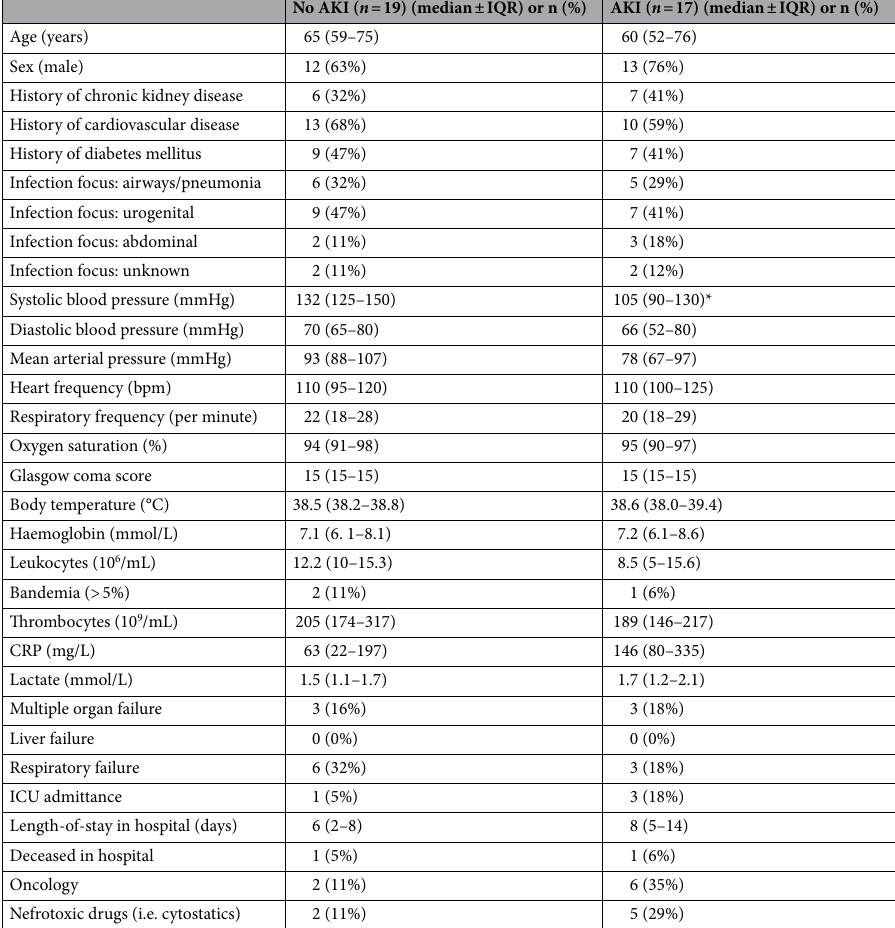
Table 1. Baseline and disease characteristics. IQR interquartile range, CRP c-reactive protein, ICU intensive care unit, */**means p <